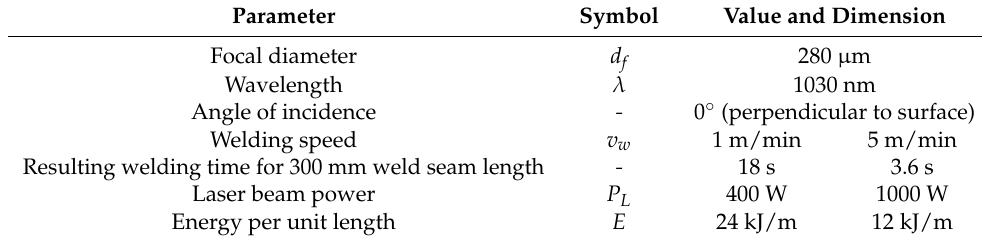
Table 1. Laser welding parameters. Parameter Symbol Value and Dimension Focal